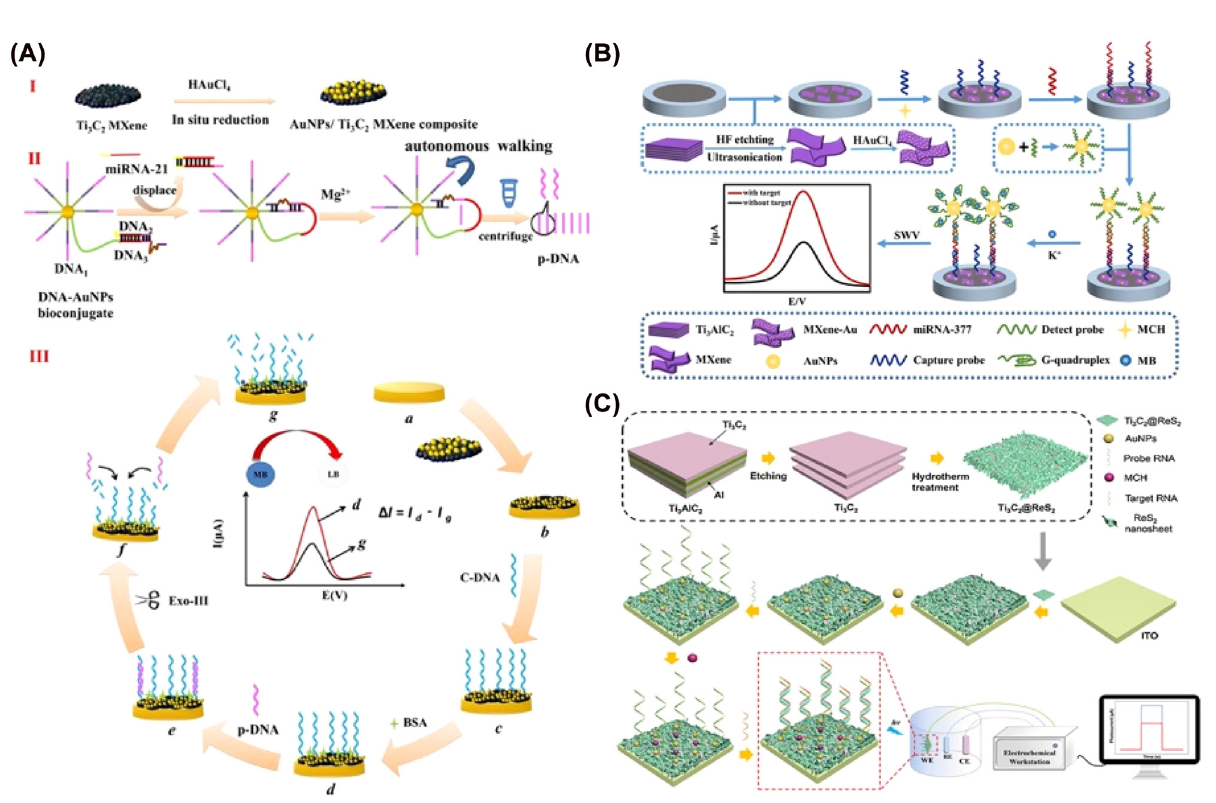
C MXenes served as an 3 2 AlC -Au 3 2 C @ReS based biosensor. Figures are 3 2 2